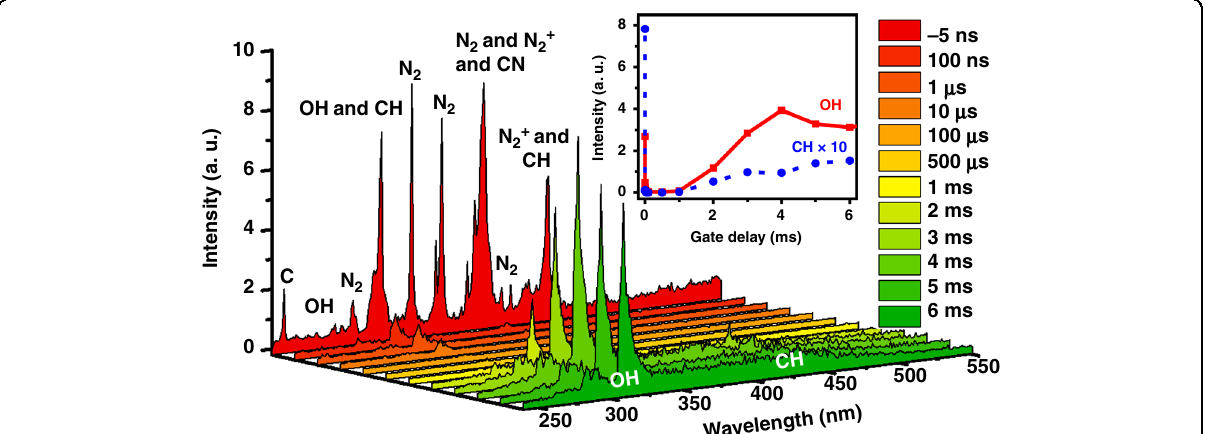
Fig. 3 Time-resolved OES spectra. Filament-induced OES spectra of the lean-fuel mixture obtained with different temporal delays of the ICCD. Inset: the signal intensities of OH (red rectangle) and CH (blue dot) radicals measured as a function of the gate delay